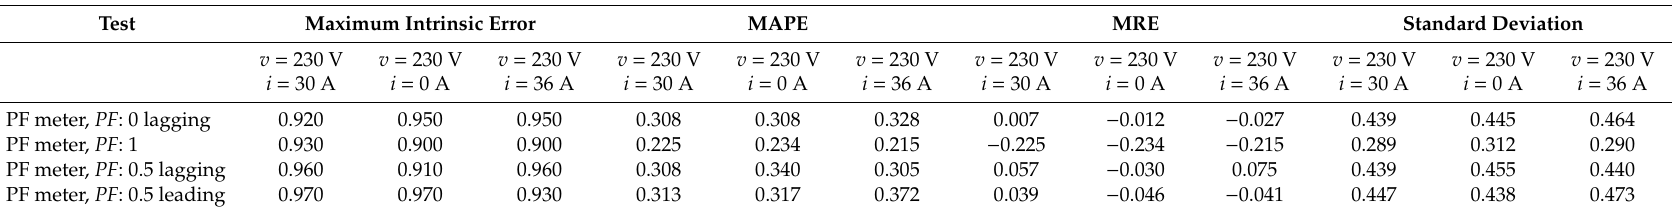
Table 9. Alternating current / voltage component variation test (PF meter, current variation): maximum intrinsic error (%), MAPE (%), MRE (%), and standard deviation (%).